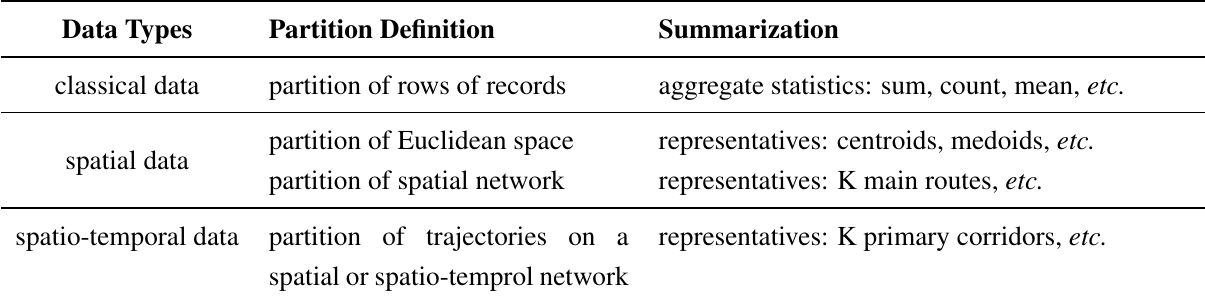
Table 5. Summarization Framework for Various Data